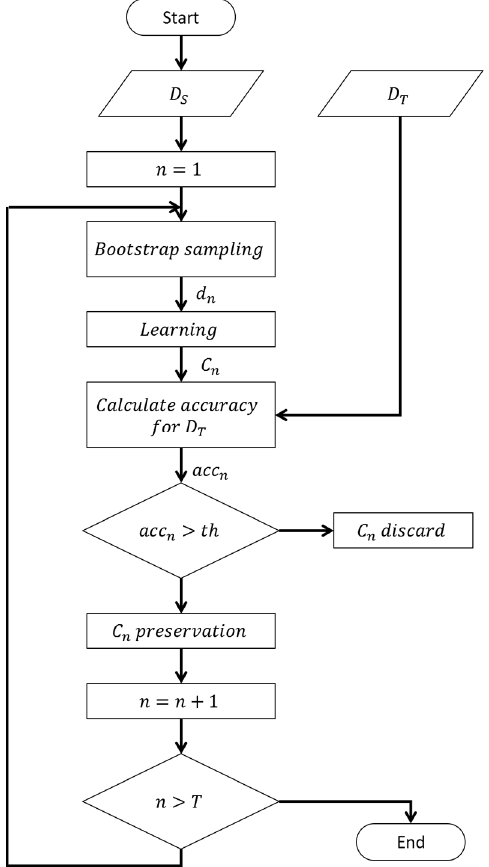
Figure 1. Flow chart of TrBagg.